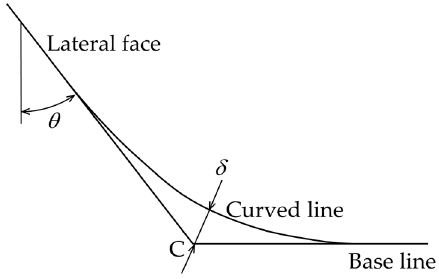
Figure 13. The forming accuracy based on distance δ from point C to the pyramid profile. Thin shell pyramids of titanium foil of D = 1.41 mm and θ = 50° formed with and without